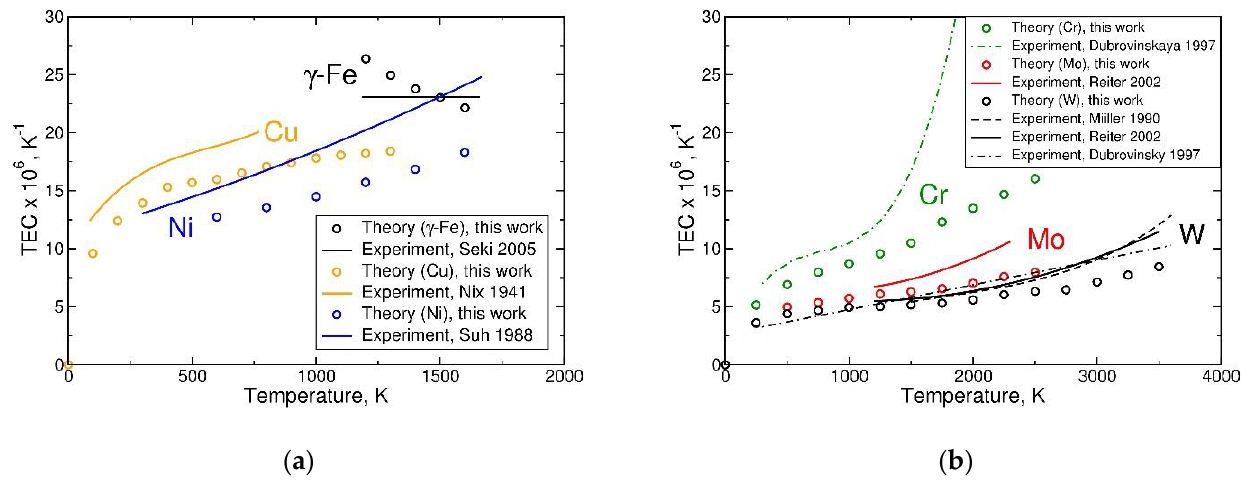
Figure 6. Thermal expansion coefficient (TEC) of selected cubic metals derived from the Helmholtz free energy: ( a ) TEC of fcc Cu, Fe, and Ni in comparison with experimental data of References [51,52,64]; ( b ) TEC of bcc Cr, Mo, and W in comparison with experimental data of References [51,58,62,65,66].